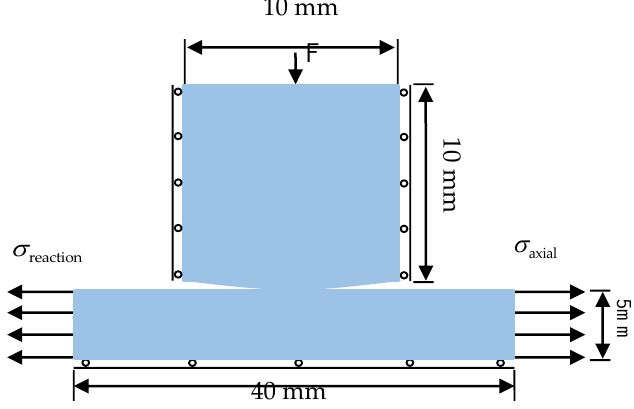
Figure 5. Configuration of the fretting fatigue numerical model.